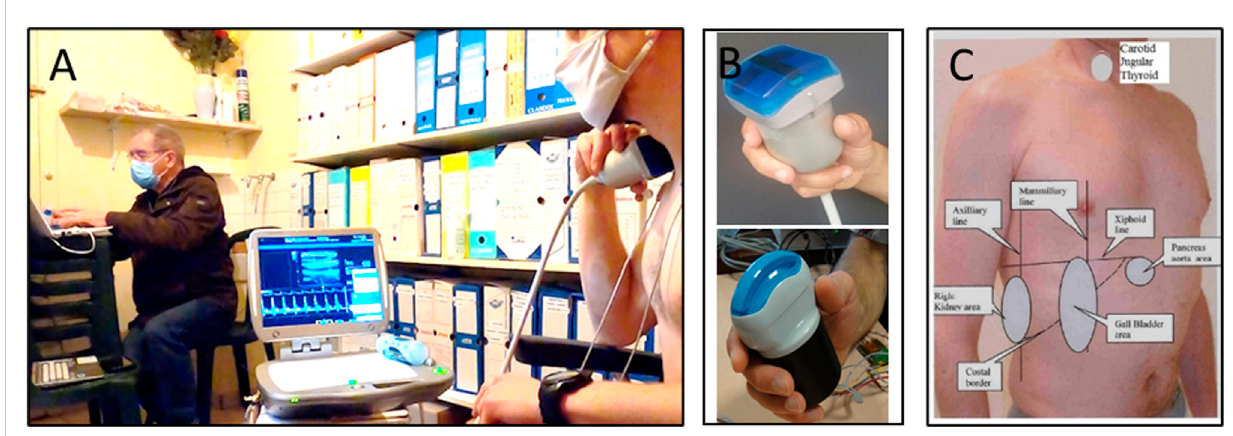
FIGURE 1 Images show the experimental setup for the ultrasound data collection. In panel (A) the participant is holding the motorized probe in place (right) while the expert sonographer (left) teleoperates the system to acquire images for analysis. Panel (B) depicts the 3.5 MHz and 17 MHz motorized probes used for the investigation. Finally, panel (C) shows the map of the various acoustic windows of each organ (ex., gall bladder, kidney) and landmarks (ex., mamillary, axillary line) used for the ultrasound assessments that was provided to the participant as reference for proper probe